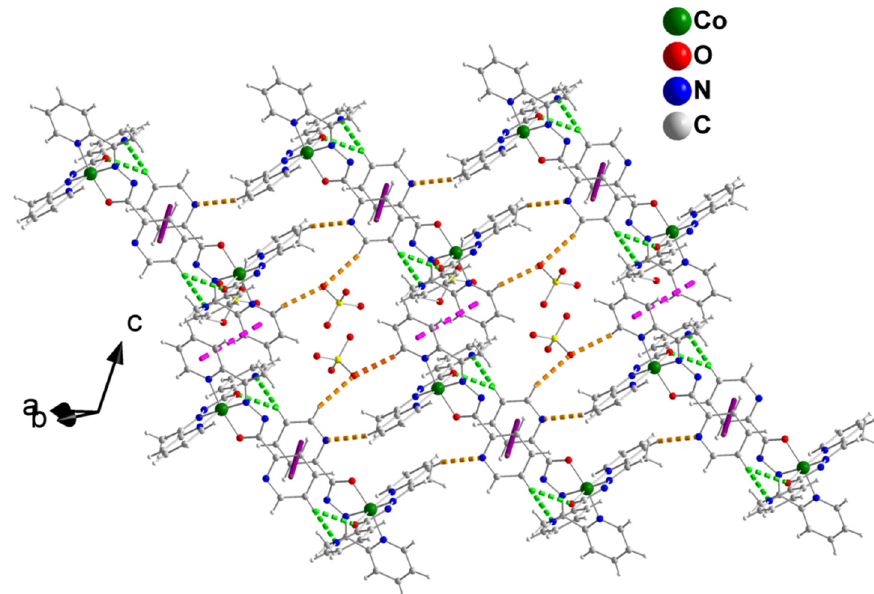
Figure 6. A layer of 4 parallel to the (1–10) plane. The dashed pink and solid violet lines indicate π – π . interactions between pairs of N1- and N4-containing rings, respectively. The dashed green lines represent the C12-H(C12) ··· N8 and C12-H(C12) ··· O2 intrachain H bonds. The dashed orange lines represent the C17-H(C17) ··· N4, C1-H(C1) ··· O5 and C13-H(C13) ··· O5 interchain H bonds. Atoms C1, C12, C13 and C17 are aromatic carbon atoms not labelled in Figures 5 and S4. Atom O5 belongs to the ClO 4 − counterion not shown in Figures 5 and S4.